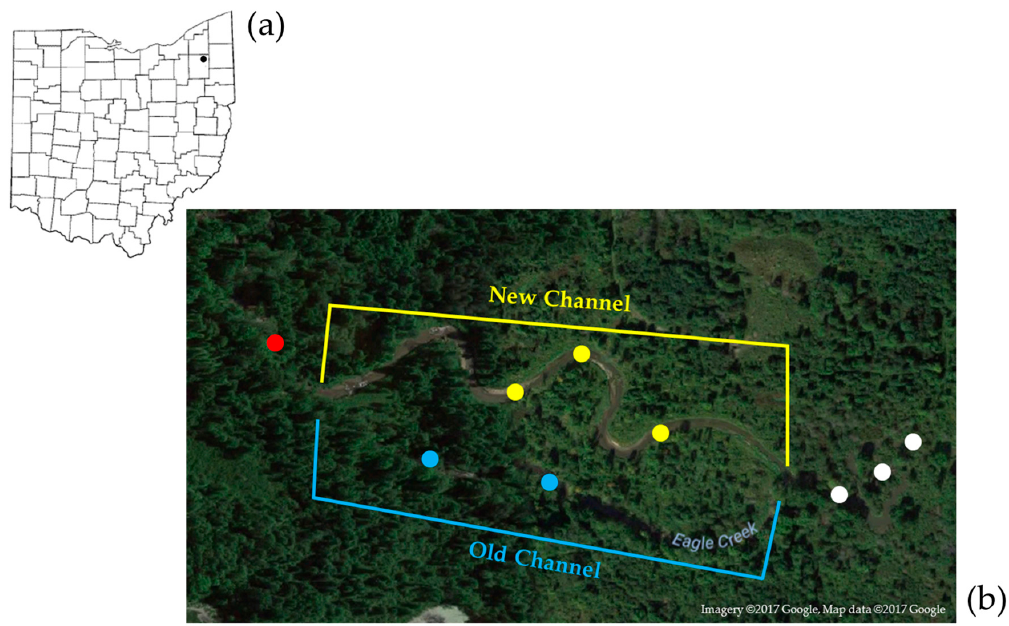
Figure 1. Maps showing ( a ) the location of Hiram College’s Eagle Creek restoration site represented by the black circle in northeastern Ohio, USA; and ( b ) an aerial view of the nine sampling sites within Eagle Creek, with New Channel and Old Channel locations bracketed. Site designations are as follows: upstream control site (red circle), old channel sites (blue circles), new channel sites (yellow circles), and downstream of the newly reconfigured channel (white circles).